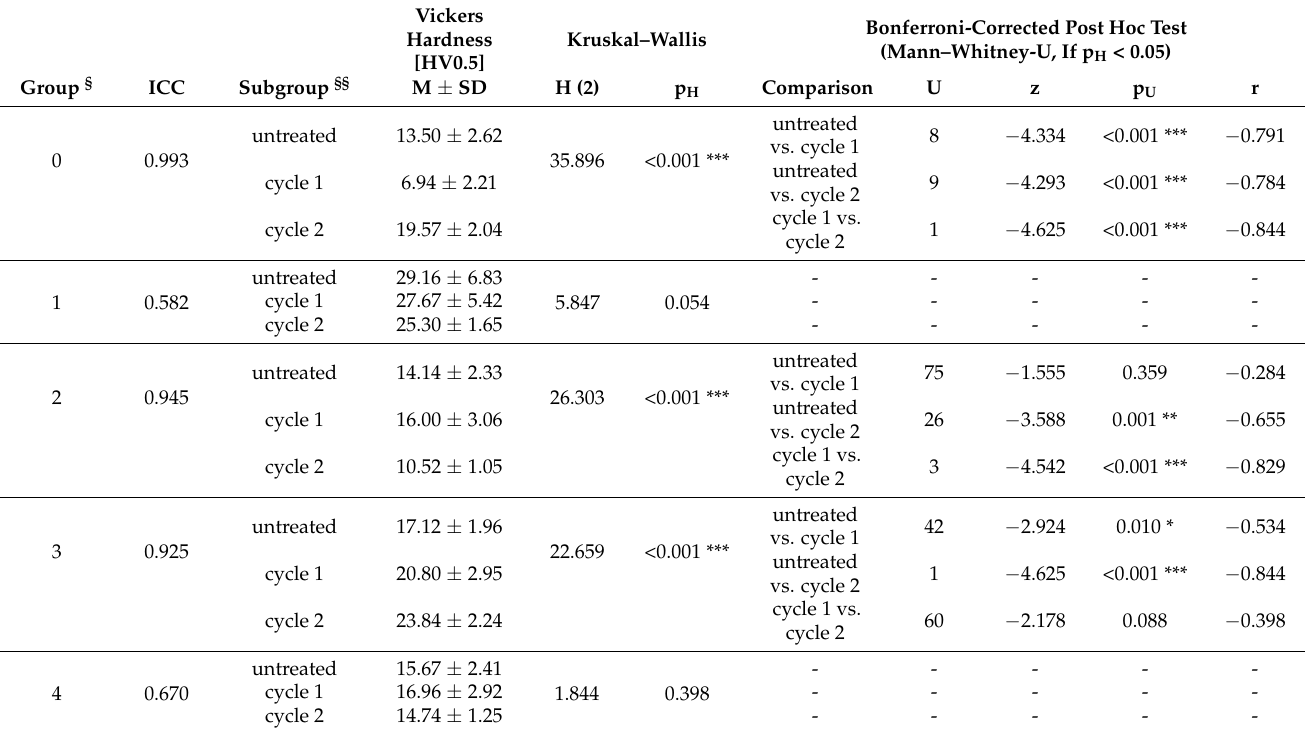
Table 2. Results of the Vickers hardness test and statistical